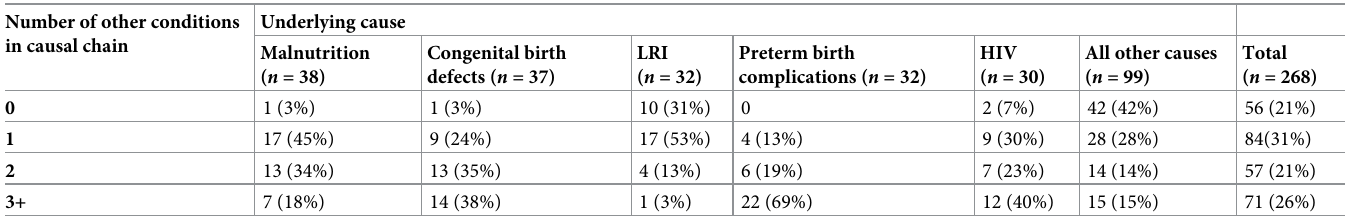
Table 7. Number of conditions in causal chain: Infants.